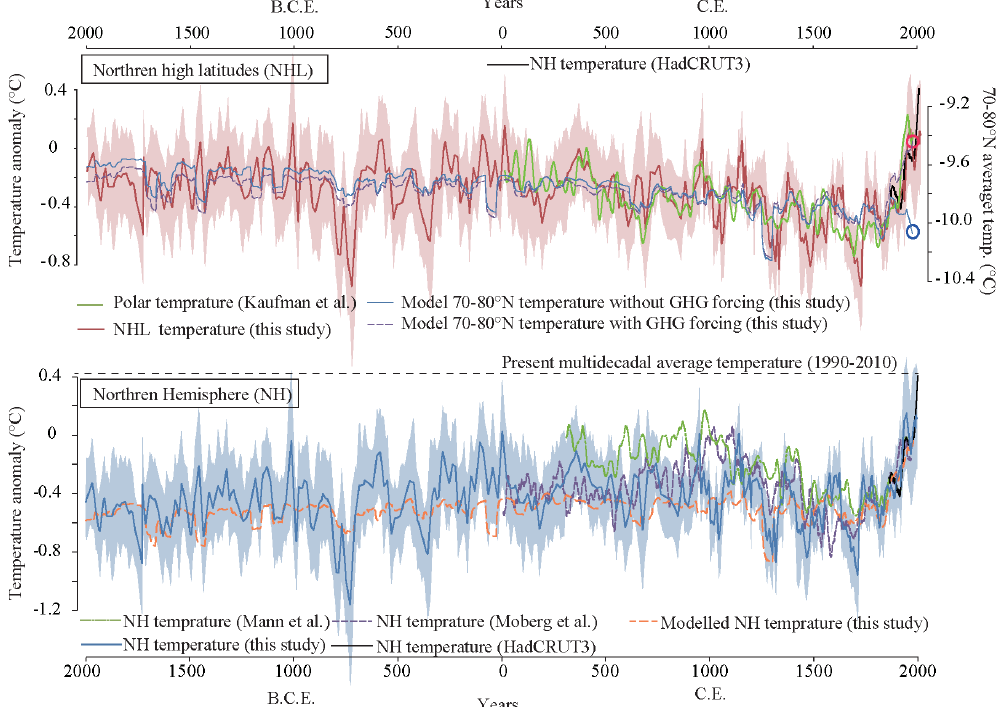
Fig. 8. Modelled and ice-core-derived northern high-latitude and NH temperature anomalies (from the base year of 1961–1990). Top panel: northern high latitudes (NHL) temperatures. Red line is the NHL temperature derived from the ice-core-derived Greenland temperature (Kobashi et al., 2011) with 2 σ uncertainty band. Green line is a multi-proxy polar temperature record in 21yr RMs (Kaufman et al., 2009). Blue and purple lines are the model outputs for 70–80 ◦ N average temperatures with all forcings and with all but excluding greenhouse gas forcing over the past 4000yr, respectively. Black line is observed NH temperature anomalies in 21yr RMs for the period from 1860 to 2000CE (HadCRUT3) (Brohan et al., 2006). Red and blue circles indicate the temperatures with all and with all excluding greenhouse gas forcing at 1976CE (the end year of model calculation), respectively. Note that left and right y axes have the same scale but with different absolute values. The NHL temperature from the ice-core-derived Greenland temperature was derived from the relationship in Eq. (3) with k =1 ± 0.5, and s NHT and X NHT are from the observed NH average temperature in 21yr RMs (HadCRUT3) (Brohan et al., 2006). Bottom panel: reconstructed NH temperature anomaly. Blue line is the NH average temperature estimated from the Greenland temperature record with the 2 σ uncertainty band. The record was calculated by adjusting the slope of the NHL temperature to be equal to the slope of the modelled NH temperature for the period of 2000BCE–1850CE. Black line is the observed NH average temperatures (HadCRUT3) (Brohan et al., 2006) in 21yr RMs. Green and purple lines are two proxy NH average temperatures by Mann et al. (2008) and Moberg et al. (2005) in 21yr RMs, respectively. The black dotted line is the present multidecadal temperature anomaly (0.42 ◦ C) from 1990 to 2010CE (HadCRUT3) (Brohan et al.,